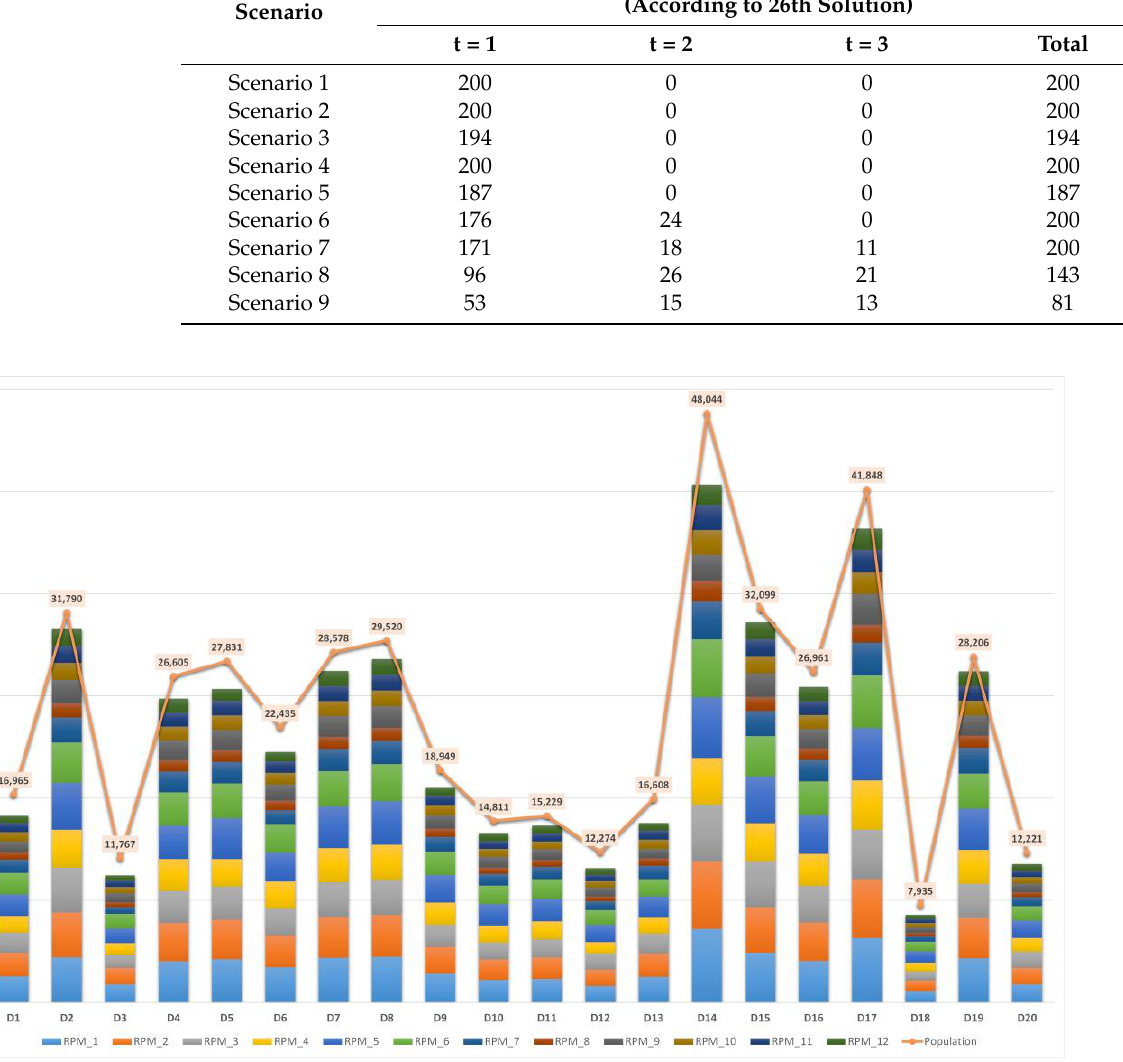
Table 5. The additional number of ambulances based on scenario and periods according to the 26th solution.